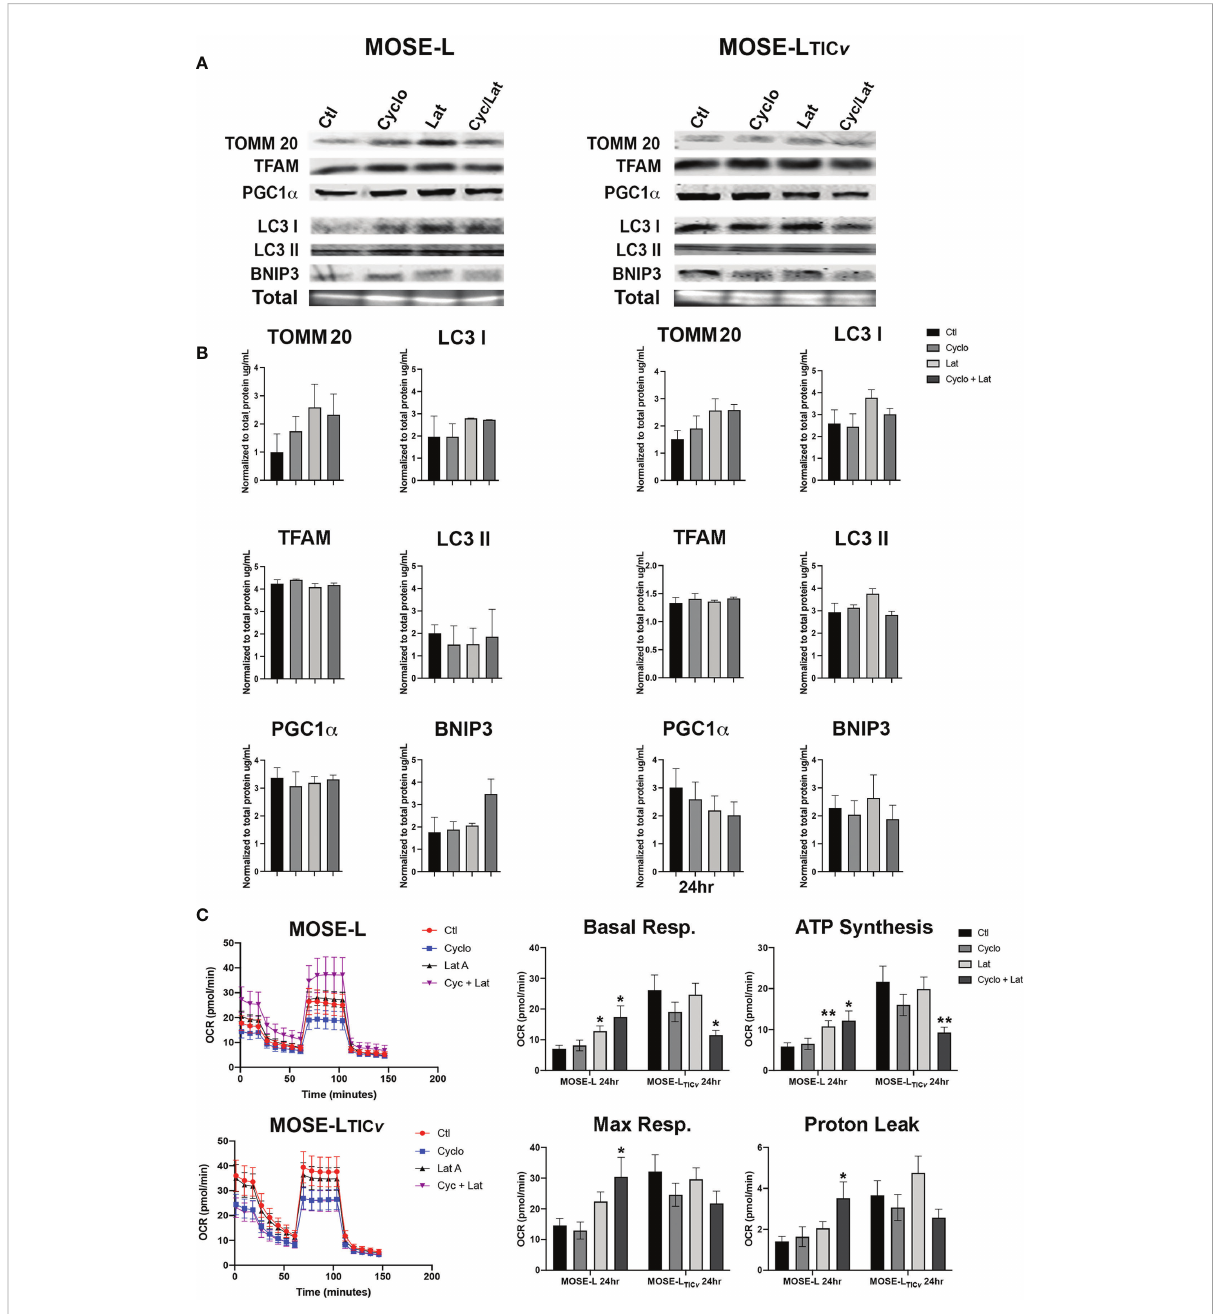
FIGURE 6 Effect of drug treatment on mitochondrial quality control and respiration. (A, B) Western blot analyses of mitobiogenic (TOMM20, TFAM and PGC1 a ) and mitophagic (LC3 I, II, and BNIP3) protein expression after 24 h treatment with100 nM Cycloheximide (cyclo), 10 nM Latrunculin A (Lat A), or both. (C) Seahorse XFe96 analysis of cellular respiration (OCR, oxygen consumption rate); *p<0.05, **p<0.01 vs .